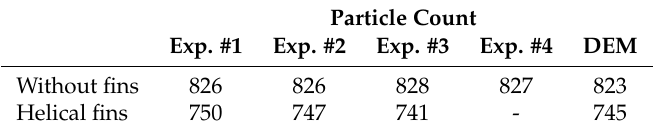
Table 3. Comparison of the particle count ( H = 600mm) between experimental and DEM